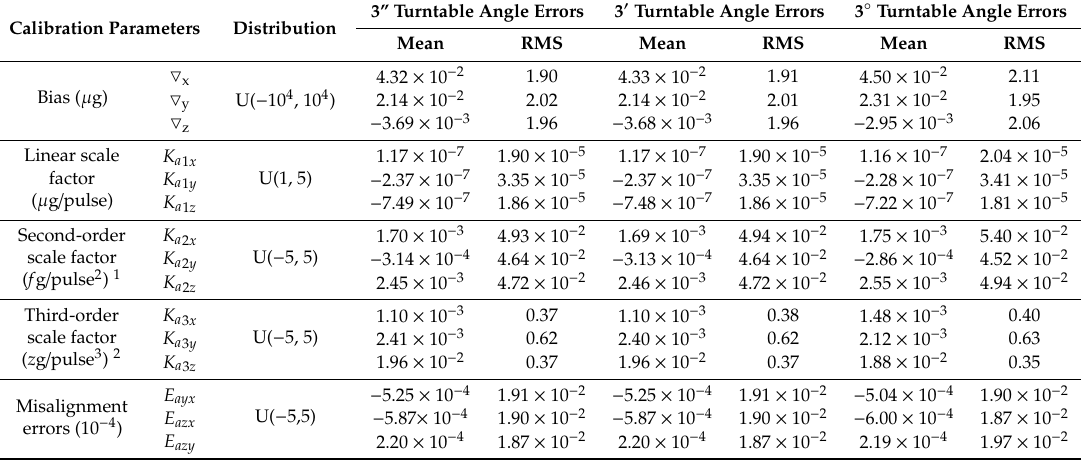
Table 2. Statistical results of Monte Carlo simulations for accelerometers.